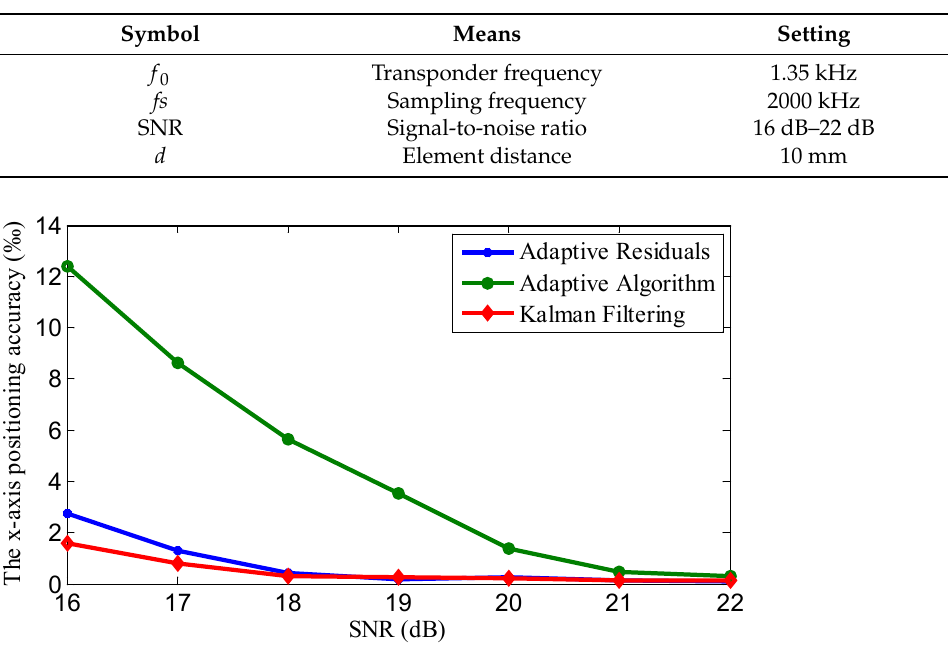
Table 2. Simulation conditions and parameters settings.